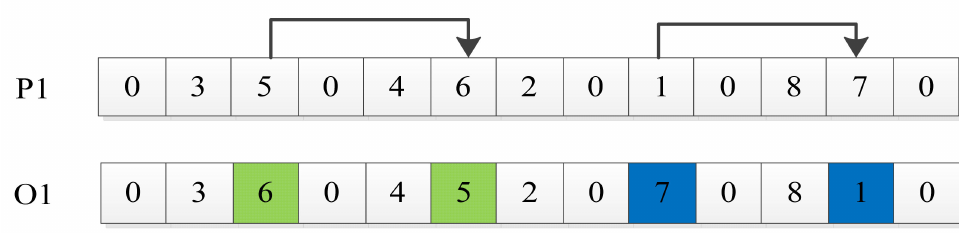
Figure 3. Multi-point mutation